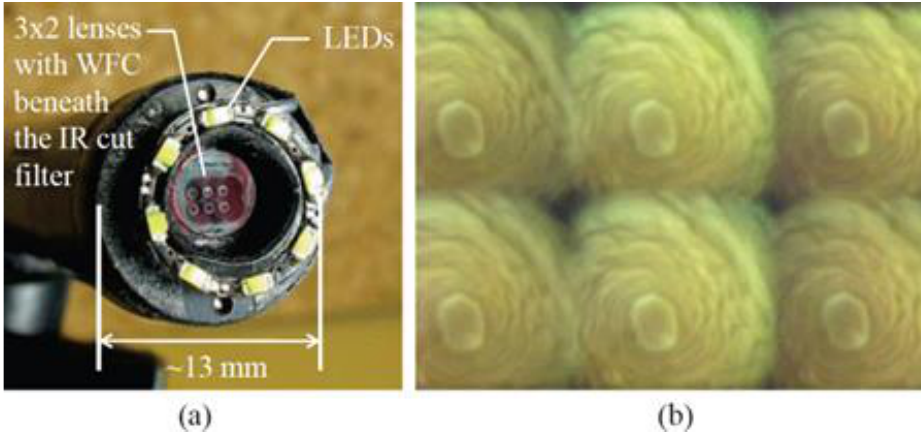
Figure 27. Photograph of the TOMBO endoscope prototype (( a , b ) show the image captured when looking inside a textured pipe with a diameter of 20 mm). Table 5. Parameters of the TOMBO endoscope prototype.